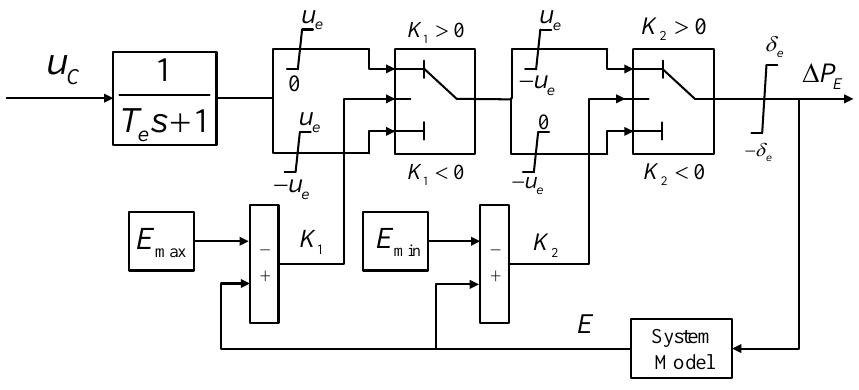
Figure 3. Plug-in electric vehicle model.